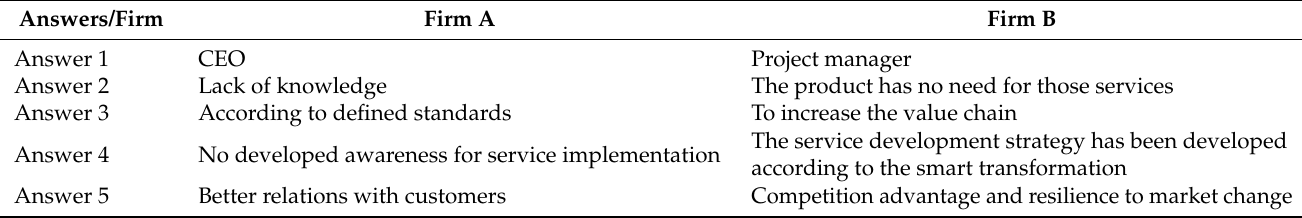
Table 6. Interviews with representatives from low-tech firms.